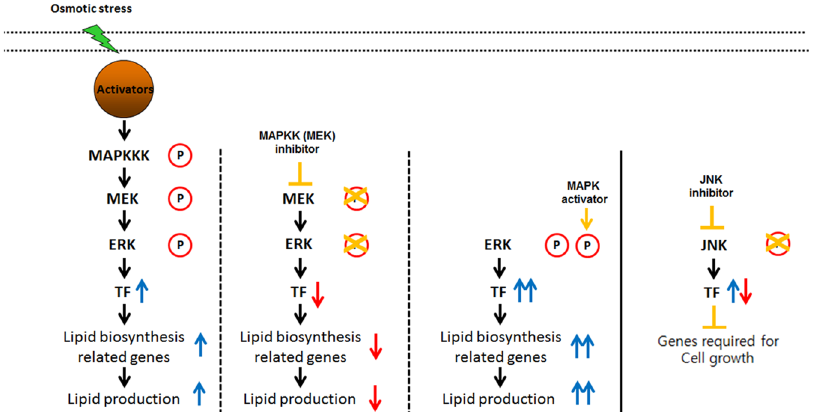
Figure 6. Proposed model of lipid biosynthesis and cell growth under osmotic